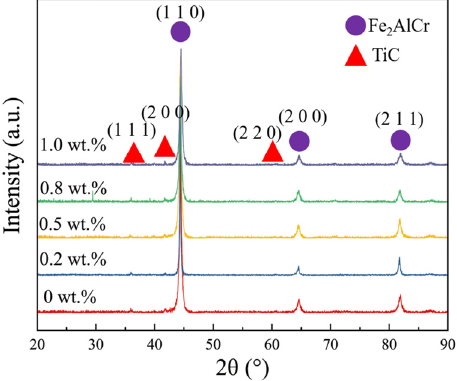
Figure 4. The XRD pattern of FeCrAlTiC-xY 2 O 3 coatings.